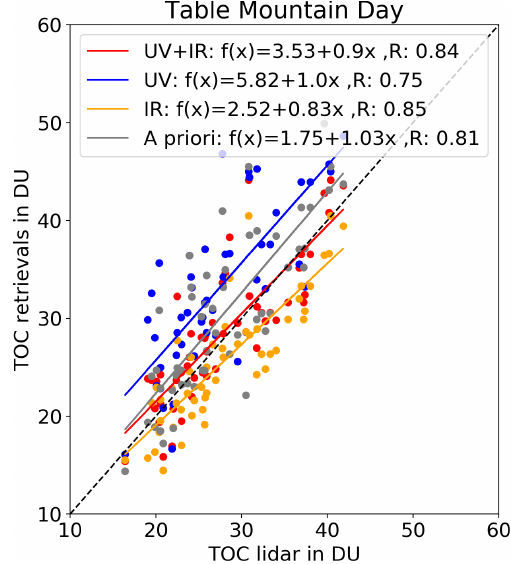
Figure 7. TOC scatter plot of TOPAS retrievals with respect to Ta- ble Mountain tropospheric lidar data (daylight measurements). The one-to-one line is given by the dashed black line. The linear regres- sion curves are plotted with different colours and their equations are given in the